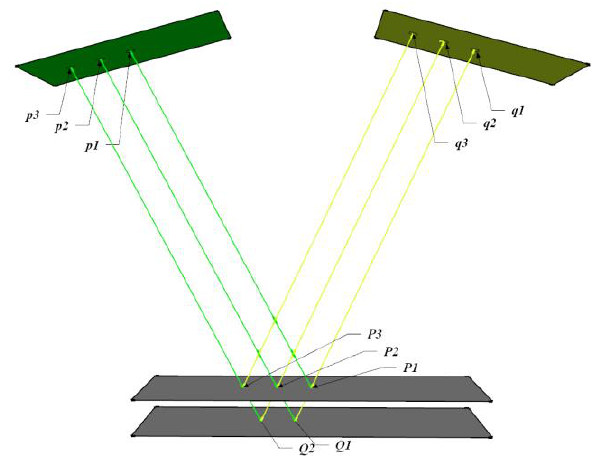
Figure 3. Tracing the approximate epipolar line using RPC information by alternatively project and back-project points between a stereo pair. The sequence generated by this step in the figure above is (𝑝 1 → 𝑃 1 → 𝑞 1 → 𝑄 1 → 𝑝 2 → 𝑃 2 → 𝑞 2 → 𝑄 2 → 𝑝 3 → 𝑃 3 ) .